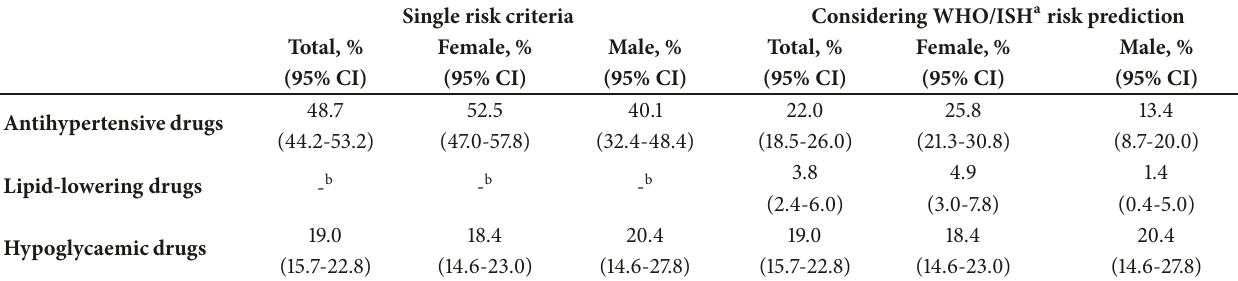
Table 3: Frequencies of individuals who require pharmacological treatment by sex. Single risk criteria Considering WHO/ISH a risk